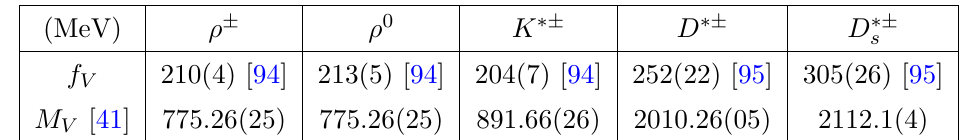
Table 9 . Decay constants and masses for (cid:26) , K (cid:3) and D (cid:3) decay constants of K (cid:3) 0 ; (cid:22) K (cid:3) 0 ( D (cid:3) 0 ; (cid:22) D (cid:3) 0 ) are the same as those of K (cid:3)(cid:6) ( D (cid:3)(cid:6) ) since they are related via isospin symmetry).